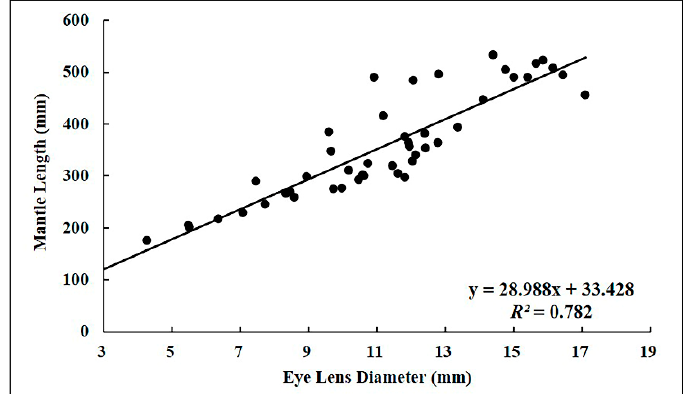
Figure 5. Scatterplot of mantle length against eye lens diameter with the regression line included.